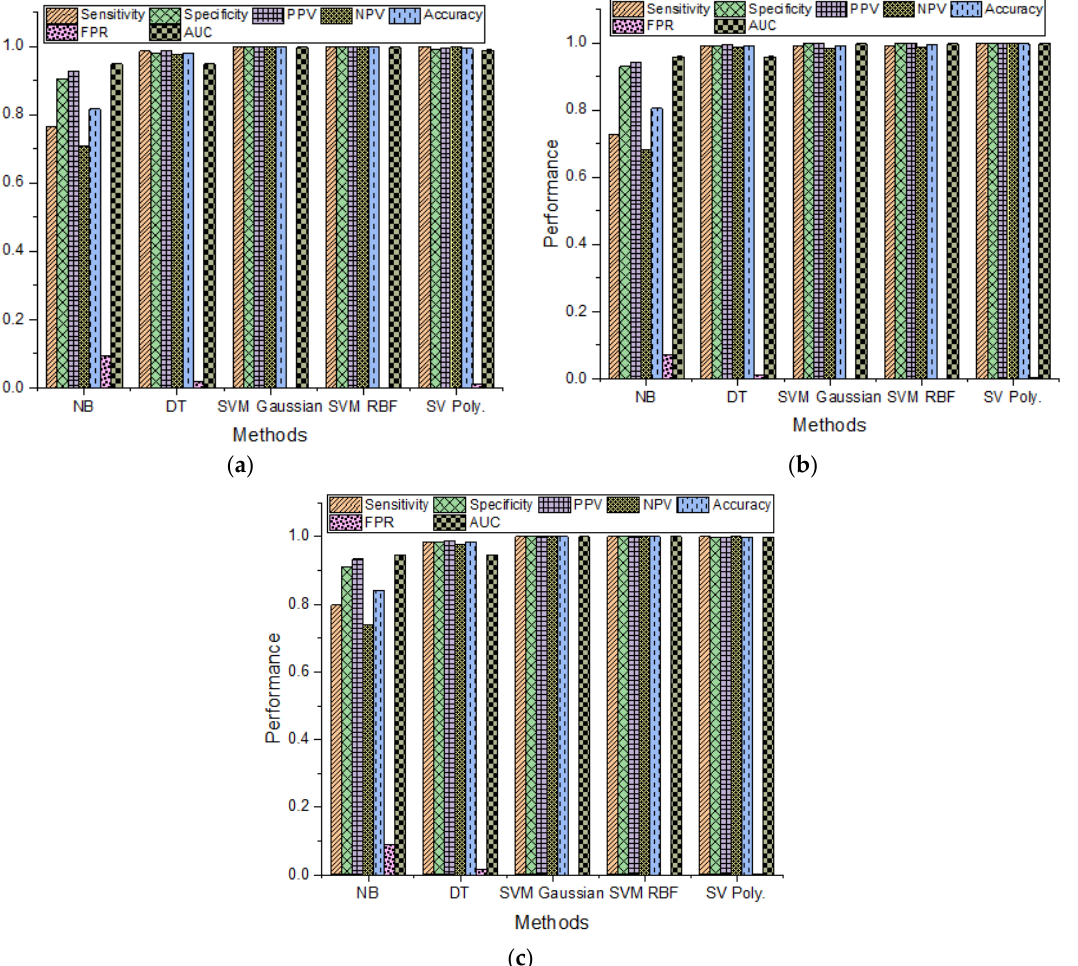
Figure 5. Lung cancer detection based on contrast stretching at different selected threshold ranges: ( a ) (0.05 – 0.95), ( b ) (0.01 – 0.90), ( c ) (0.02 – 0.98). Figure 6 indicates lung cancer detection based on the gamma correction method at different selected gamma values. Figure 6a utilized a gamma value of 0.04. The DT pro- duced the highest detection performance, with accuracy (98.15%), AUC (0.9821); followed by naïve Bayes, with accuracy (92.49%), AUC (0.9821); SVM polynomial, with accuracy (70.84), AUC (0.993); SVM RBF, with accuracy (69.21%), AUC (0.7472); and SVM Gaussian, with accuracy (0.6910), AUC (0.9941). Figure 6b utilized a gamma value of 0.3. The highest detection performance was yielded using SVM polynomial, with accuracy (98.69%), AUC (1.00); followed by decision tree, with accuracy (98.59%), AUC (0.9856); SVM Gaussian, with accuracy (96.84%), AUC (0.9989); SVM RBF, with accuracy (96.52), AUC (0.9989); SVM RBF, with accuracy (69.21%), AUC (0.7472); SVM Gaussian, with accuracy (0.6910), AUC (0.9941); and naïve Bayes, with accuracy (94.56%), AUC (0.9856). Figure 6c utilized a gamma value of 0.5. The SVM RBF yielded a higher performance, with accuracy (100%), AUC (1.00); followed by SVM Gaussian and polynomial, with accuracy (99.89%), AUC (0.9986); decision tree, with accuracy (99.134%), AUC (0.9469); and naïve Bayes, with ac- curacy (82.59%), AUC (0.9469). Figure 6d utilized a gamma value of 0.7. The SVM Gauss- ian produced the highest detection performance, with accuracy (100%), AUC (1.00); fol- lowed by SVM RBF and polynomial, with accuracy (99.89%), AUC (0.9987); decision tree, with accuracy (98.91%), AUC (0.9664); and naïve Bayes, with accuracy (85.53%), AUC